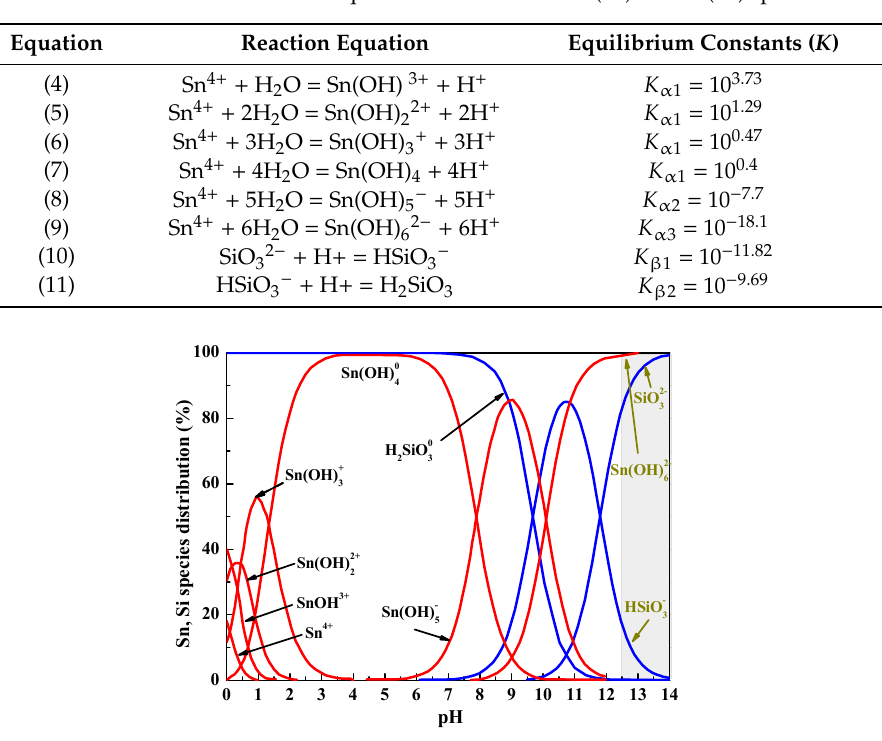
Figure 7. Mole fractions of metasilicic and stannum species at different pH values.